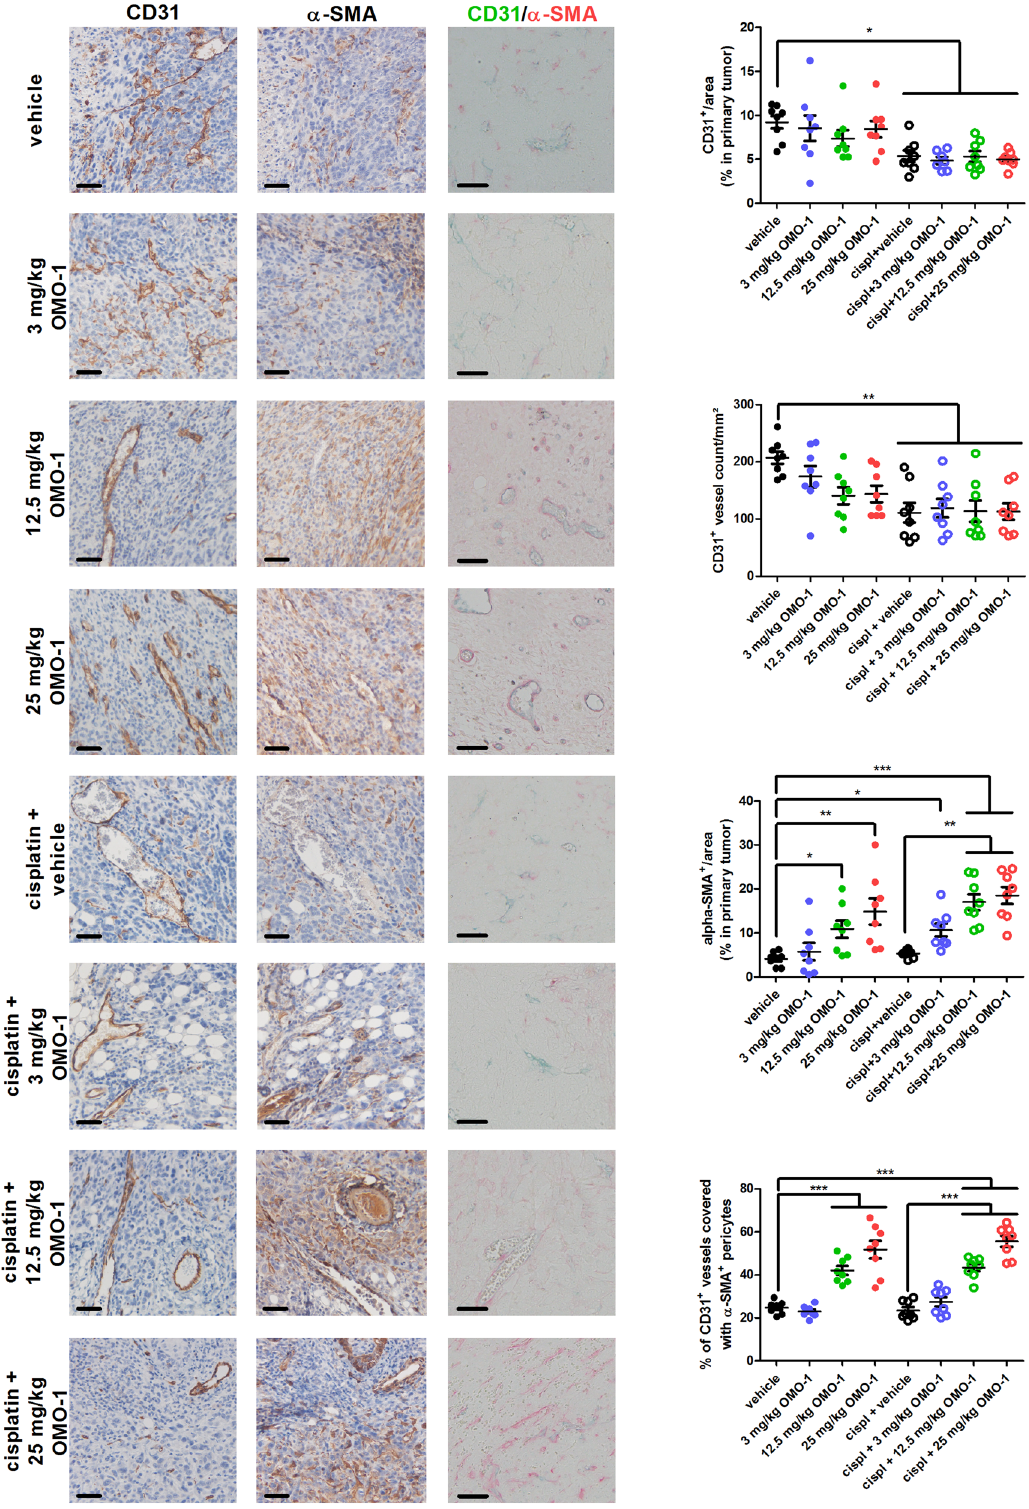
Fig. 4 OMO-1 treatment increases vascular pericytes in primary tumors of a 4T1-based intraductal model. Immunohistochemistry for the endothelial cell marker CD31 and the pericyte marker α -SMA and double staining immunohistochemistry for CD31 and α -SMA on paraf fi n sections of primary tumors from the different treatment groups at 39 days p.i. ( n = 8; 2 slides per treatment group for each marker with 4 images per slide). CD31 + vessels were manually counted on 20× magni fi ed microscopic images. The proportion of α -SMA-covered CD31 + vessels among total counted CD31 + vessels was also determined on 20× magni fi ed microscopic images. Scale bars = 50 µm. Data are presented as the means ± SEM. * P < 0.05, ** P < 0.01, *** P < 0.001. Published in partnership with the Breast Cancer Research Foundation npj Breast Cancer (2021)